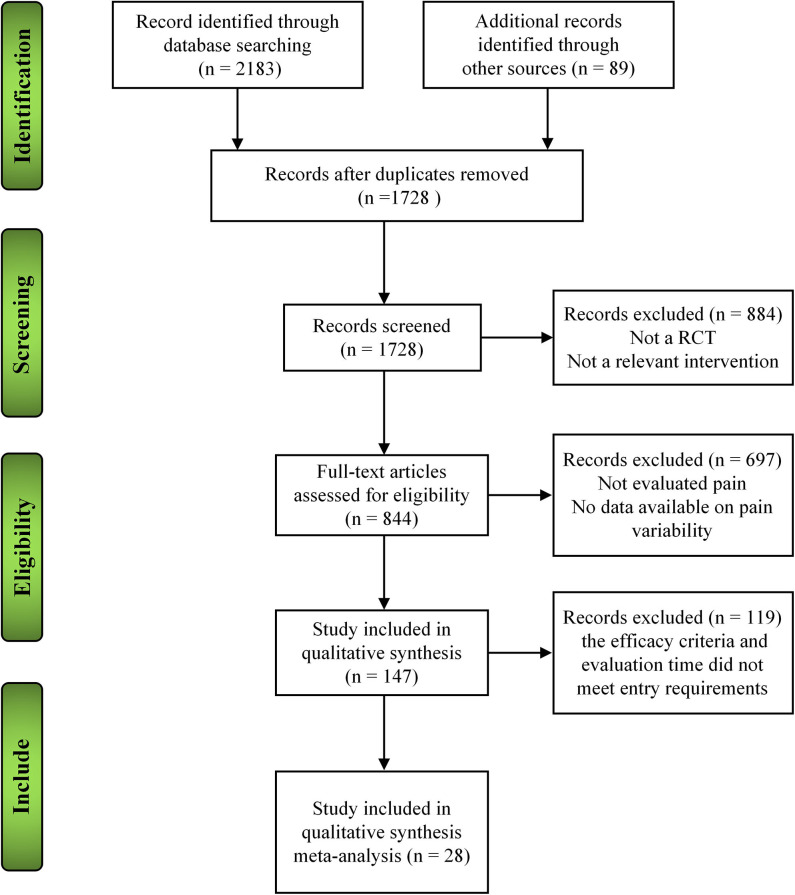
The different phases of the search of the 8 databases and the selection of the studies included in the present analyses.